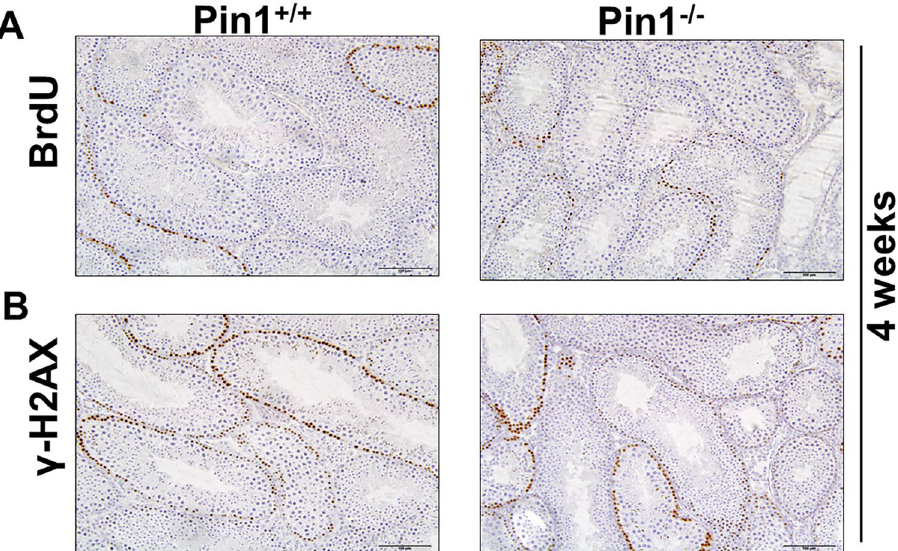
Figure 2. Loss of Pin1 does not hamper progression of meiosis or proliferation. ( A ) BrdU staining was observed in Pin1 − / − mouse testicular tissue at 4 weeks of age. Mice were injected with BrdU (100 µ g/gram body weight) 12 hours prior to sacrifice. ( B ) γ -H2AX immunostaining was observed in the same tissue to analyze the progression of meiosis (scale bar = 100 µ